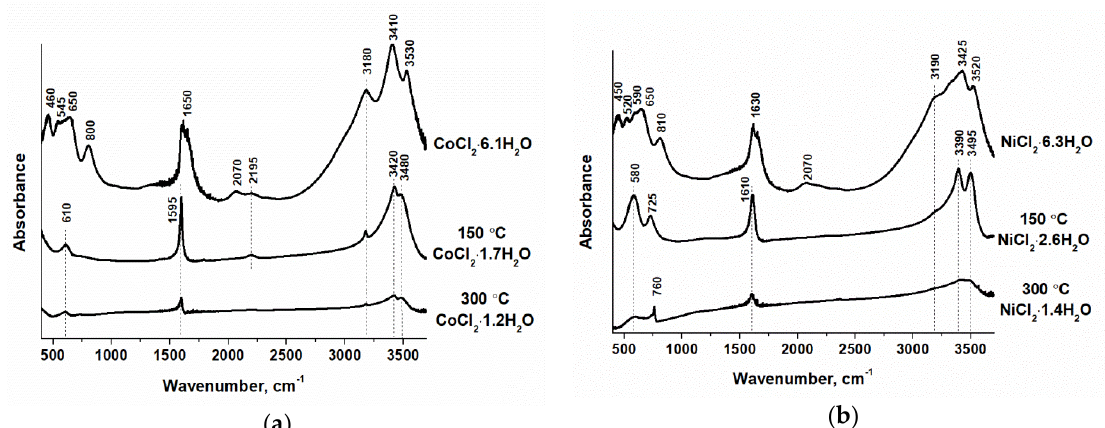
Figure 2. FTIR spectra of ( a ) cobalt chloride hydrate, ( b ) nickel chloride hydrate and their partially dehydrated species obtained under isothermal condition.